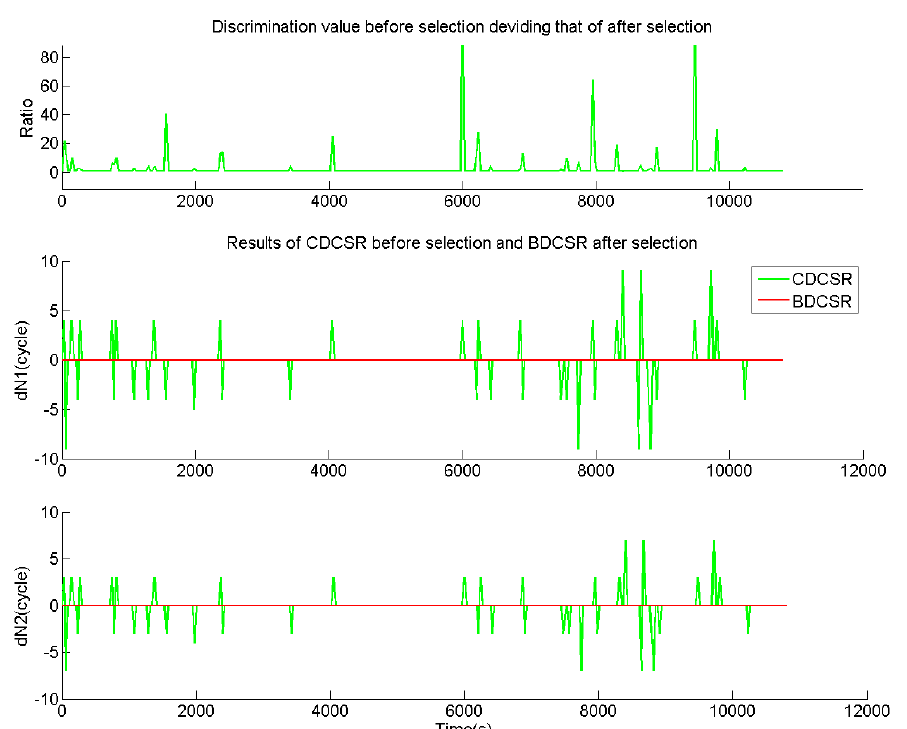
Figure 11. Results of CDCSR before selection and BDCSR after selection with the discrimination function from IGSO Satellite 6 in a weak condition of low elevation during the geomagnetic storm, where the phase data without cycle slip was collected at the CUT0 station started from UTC 8 May 2016 00:00:00 with an interval of 30 s.